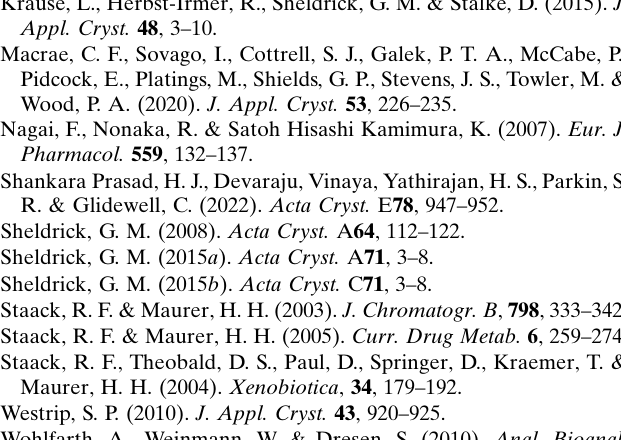
Data collection